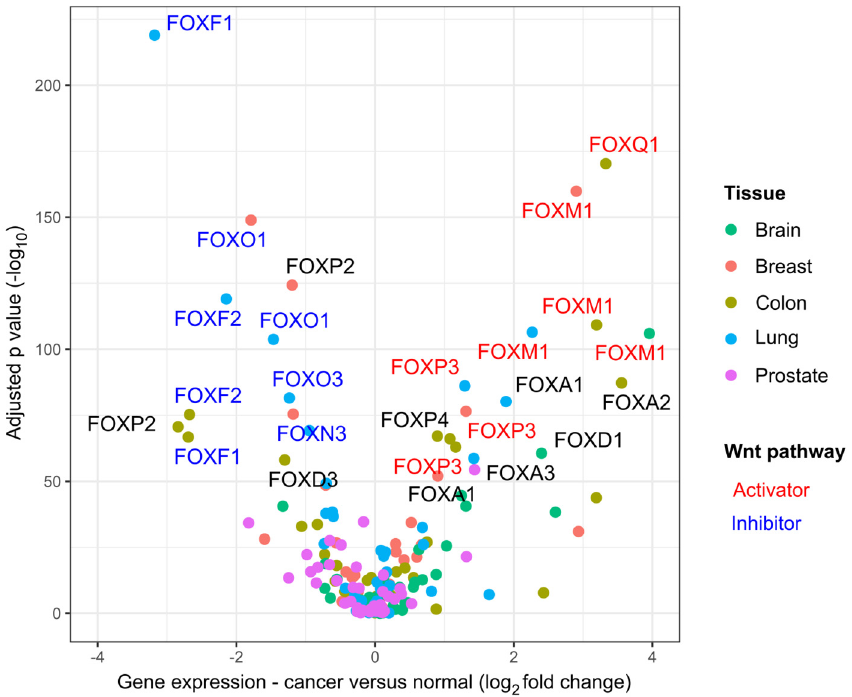
Figure 2. Gene expression changes of FOX transcription factors in selected cancers. Data sources are indicated in the data availability statement at the end of the manuscript. Classification of genes as Wnt pathway activators or inhibitors is based on the literature, see Table 1. Only data points with >2-fold change in expression and an adjusted p value < 10 − 50 are labeled.